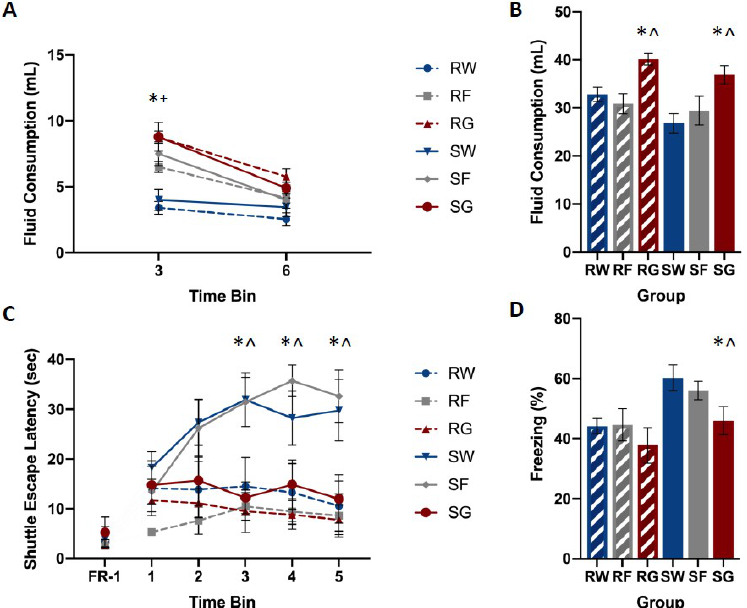
Figure 3. Mean fluid consumption at 3 and 6 h post-stress (panel A ) and 18 h post-stress (panel B ), escape latencies (panel C ), and percent freezing for FR-1 trials (panel D ) among groups. Rats